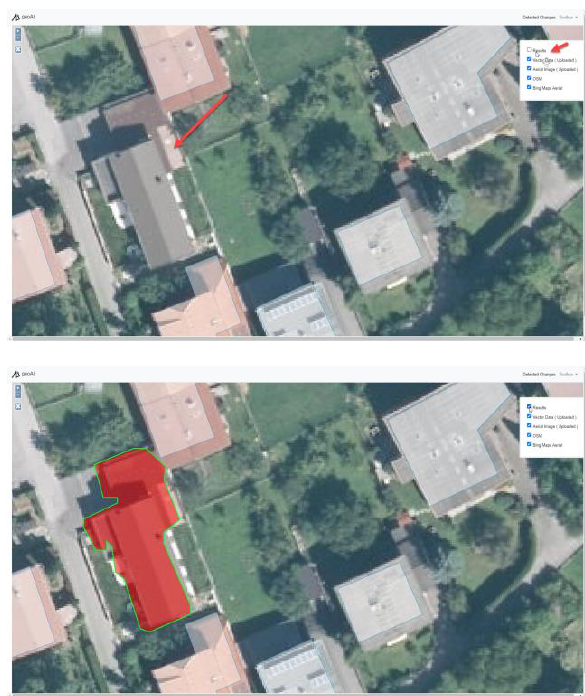
Figure 11. The layer switcher menu updated after the change detection is completed, and the location of one missing building in the ground truth (above), and the DL segmentation result below.